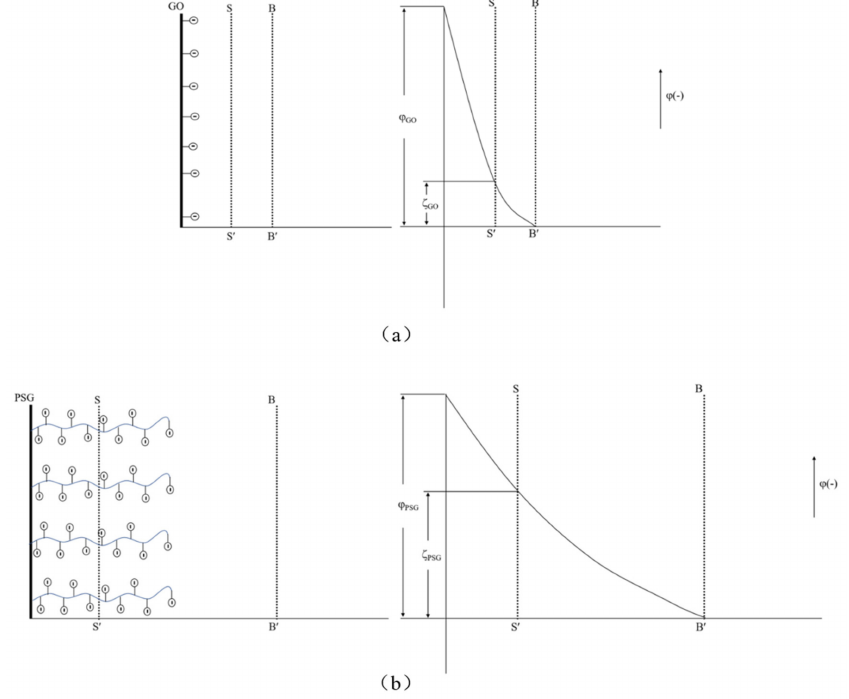
Figure 18. Zeta potential diagram of GO surface and PSG surface: ( a ) GO; and ( b ) PSG. When GO and PSG were doped into a system containing Ca 2+ , the COO − groups contained on the surface of these materials complexed Ca 2+ [23–25], thereby absorbing Ca 2+ on the surface of the sheets. This complexation interaction affected the surface